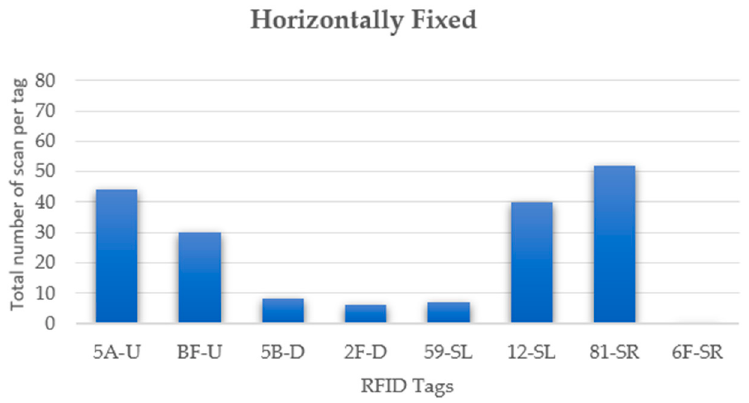
Figure 14. The total number of scans per tag type and orientation when the sUAS was flown with a fixed horizontal position at three different altitudes (4.5 m, 6.0 m, and 7.6 m) for 1 min.